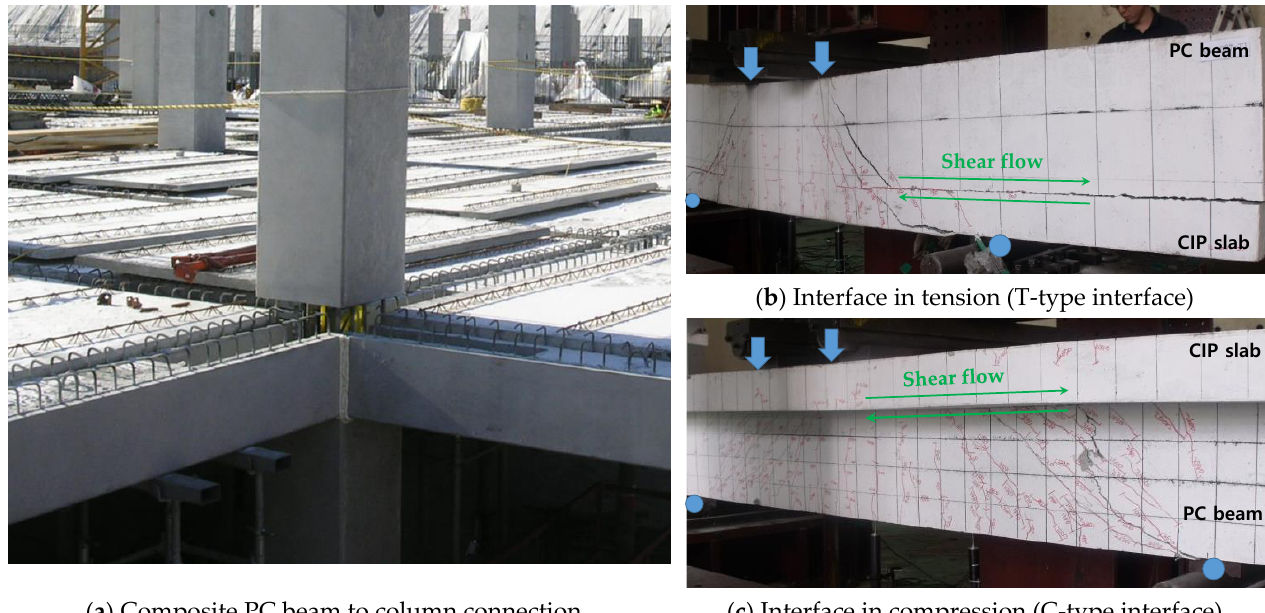
Figure 1. Interface location and principal stresses of the composite PC beams.